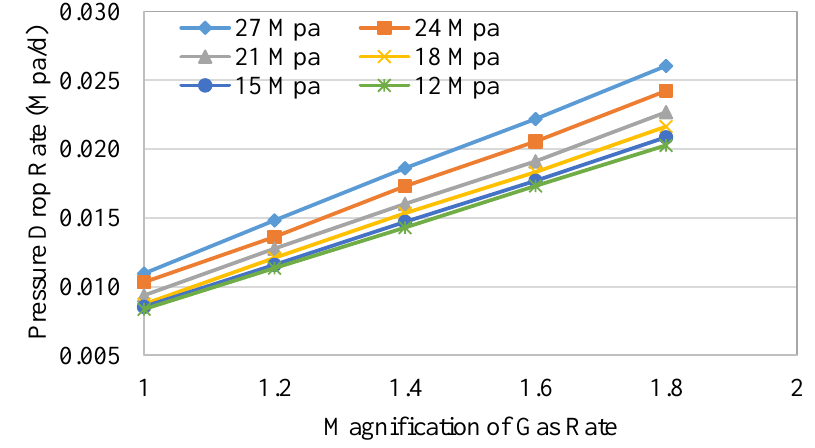
Figure 5—Correlation of pressure drop rate and increment of gas rate of type II